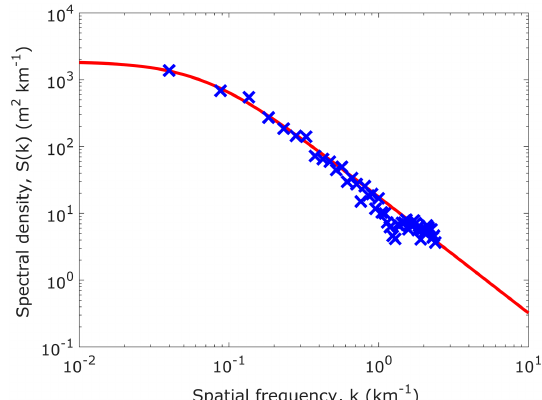
Figure 13. Composite power spectral density from fjord bed ele- vation profiles. Blue crosses indicate spectral data that have been averaged over nine fjord profiles, and the solid red curve is the best fit to the parametric model, Eq.